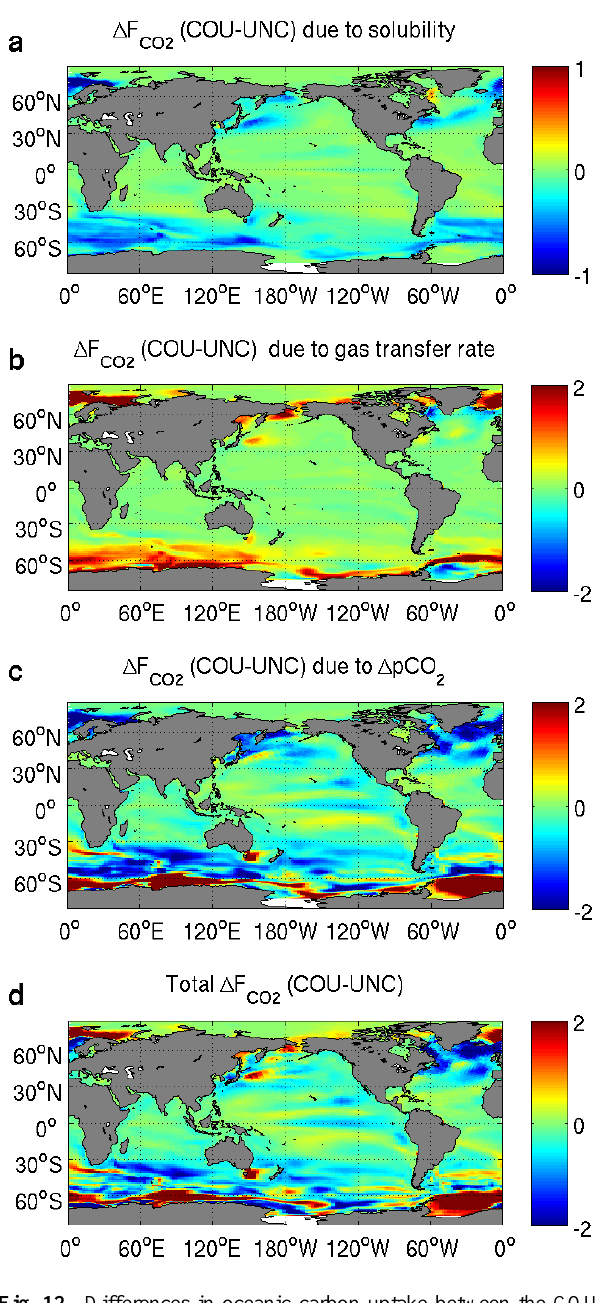
Fig. 12. Differences in oceanic carbon uptake between the COU and UNC (2080–2099) due to the (a) solubility, (b) gas trans- fer velocity, (c) difference in partial pressure of CO 2 effects, and the (d) total simulated carbon uptake difference. Units are in [molesCm − 2 yr − 1 ]. Positive values represent more carbon uptake when climate change is taken into consideration, whereas negative values represent the opposite.